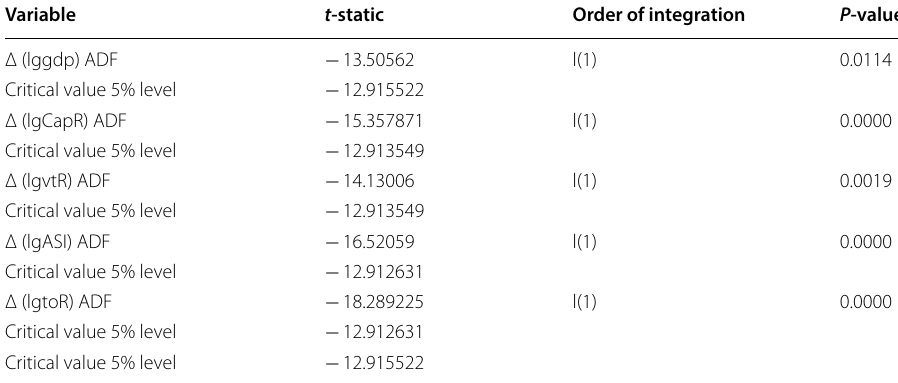
Table 8 Augmented Dickey–Fuller Unit Root Test results (linearized model)